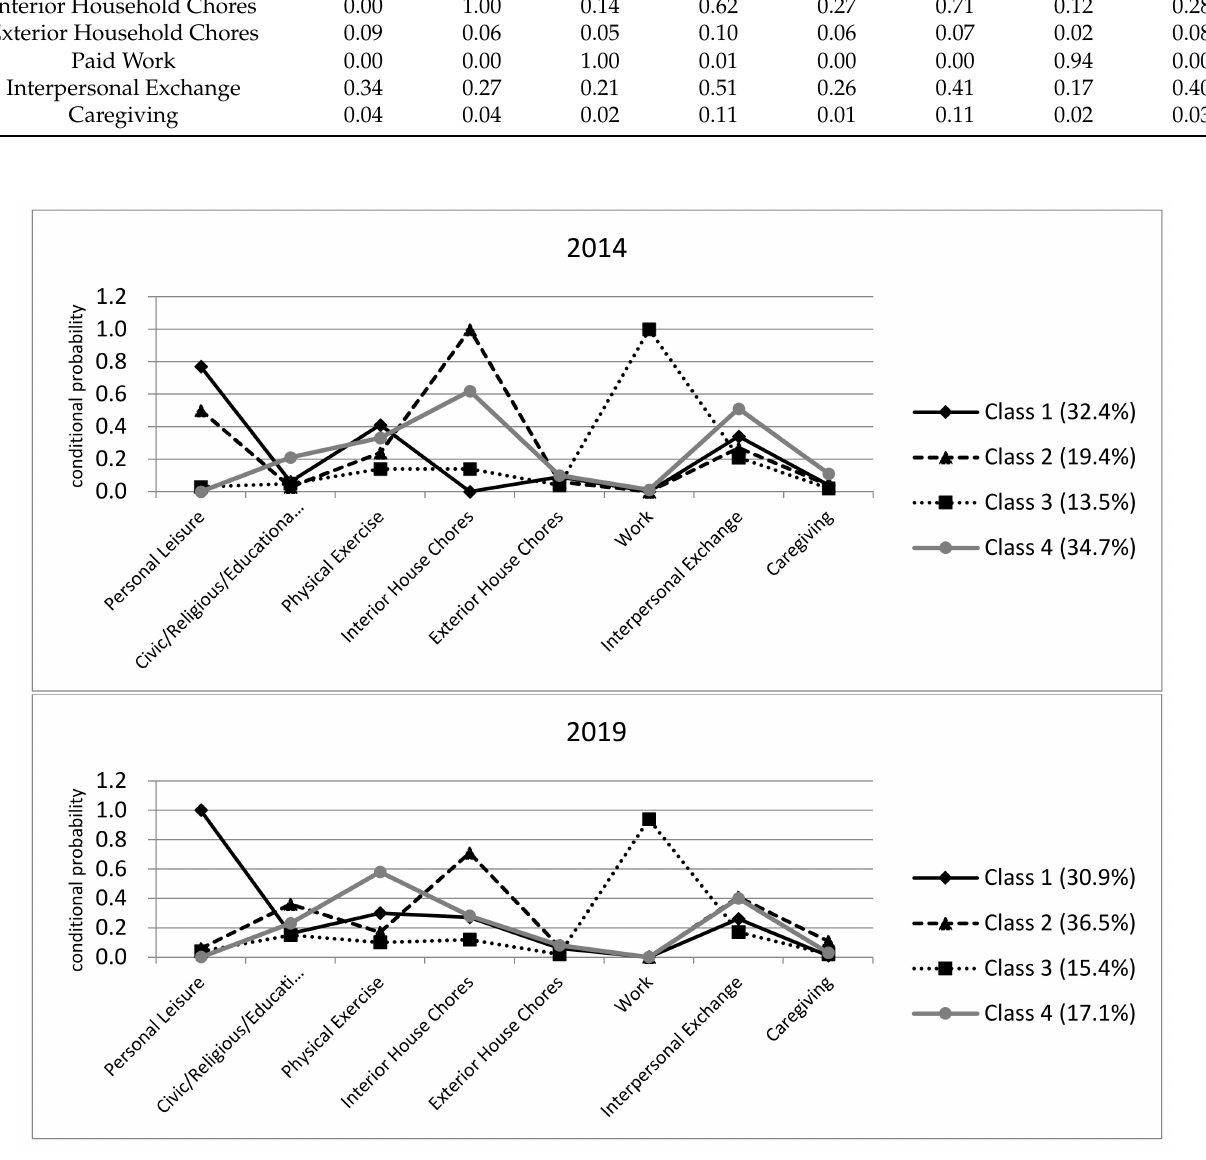
Figure 2. Activity profiles for Korean older adults: Findings from the